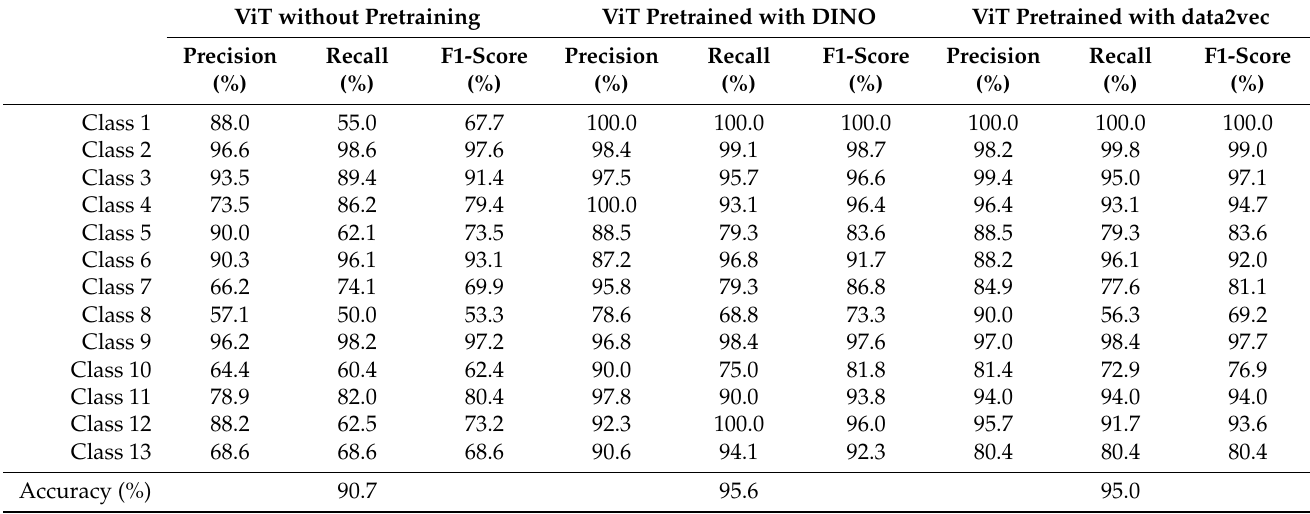
Table 3. Comparison of classification reports of the ViT model with and without self-supervised